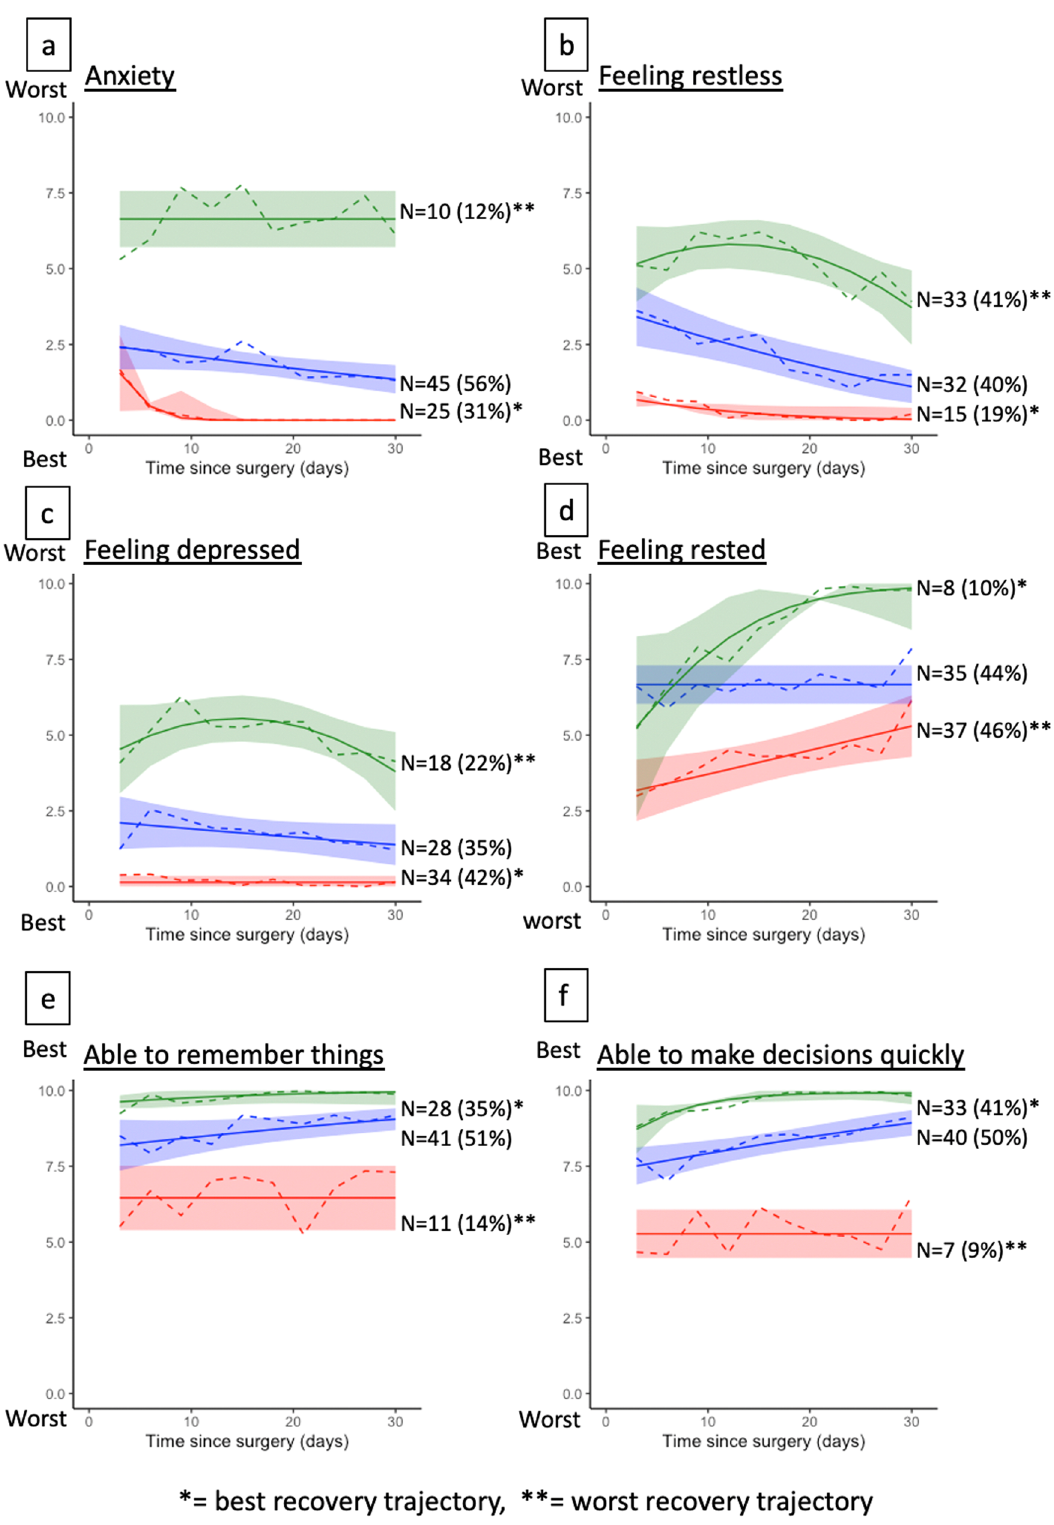
Fig. 2 Trajectories of recovery by emotive and cognitive domains. The fi gure shows trajectories of recovery in cognitive and emotive domains. All questionnaire responses in these domains yielded three dominant trajectories. Trajectories with single asterisk (*) denotes the best recovery trajectory and those with double asterisks (**) denote the worst trajectory. Colors are used for visualization purposes and do not correspond to better or worse trajectories. Patients ’ level of anxiety ( a ), restless feeling ( b ), depressed feeling ( c ), rested feeling ( d ), being able to remember things ( e ), and being able to make decision quickly ( f ) are